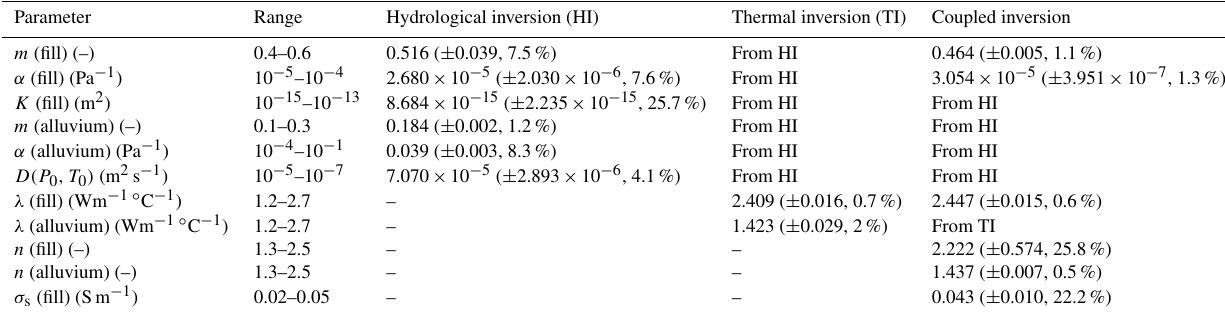
Table 1. Constraints and estimated values of the hydrological-thermal and petrophysical parameters for different inversion cases. Hydrolog- ical inversion used matric potential data to estimate hydrological parameters ( m (fill, alluvium), α (fill, alluvium), K (fill) and D ). Thermal inversion used subsurface temperature data to estimate thermal conductivity of both fill and alluvium layers – λ (fill, alluvium). Coupled in- version used all matric potential, temperature and apparent-resistivity data to estimate parameters m (fill), α (fill), λ (fill), n (fill), n (alluvium) and σ